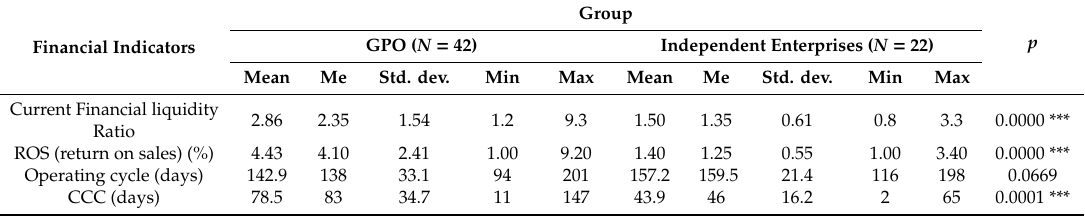
Table 2. Statistics on the distribution of financial indicators in both groups compared.